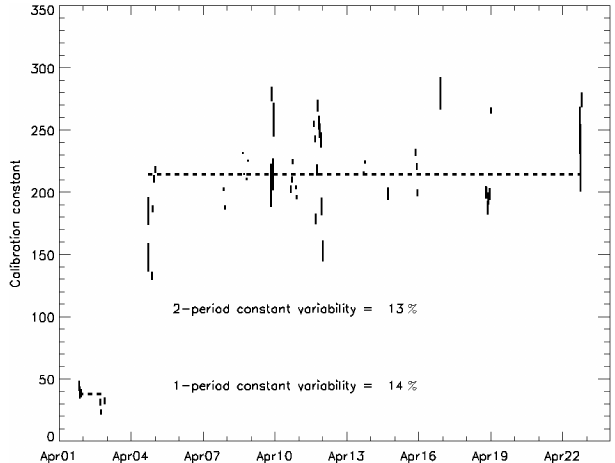
Figure 7. Time series of lidar calibration factors with their associ- ated errors for the RMR-H 2 O lidar determined by IWV GPS during the MALICCA campaign. Dashed horizontal lines indicate the me- dian values for the ISPs identified by the CL monitoring